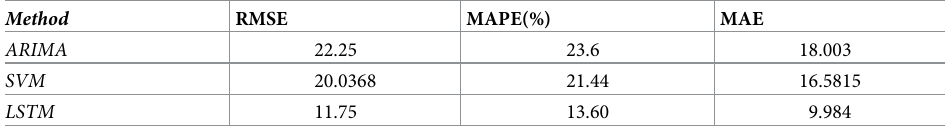
Table 6. Results of different models for monthly cases number prediction.